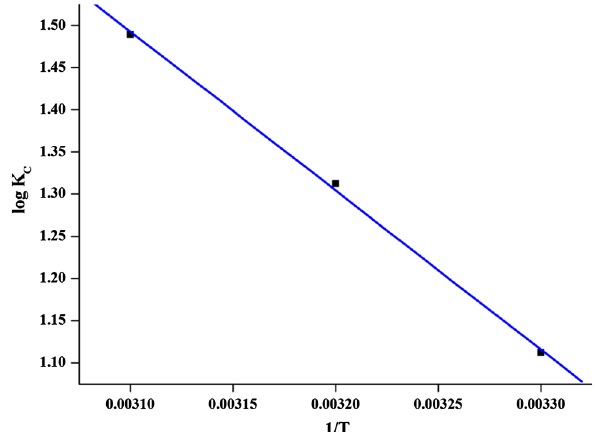
Fig. 13 Adsorption thermodynamics for the adsorption of CV onto